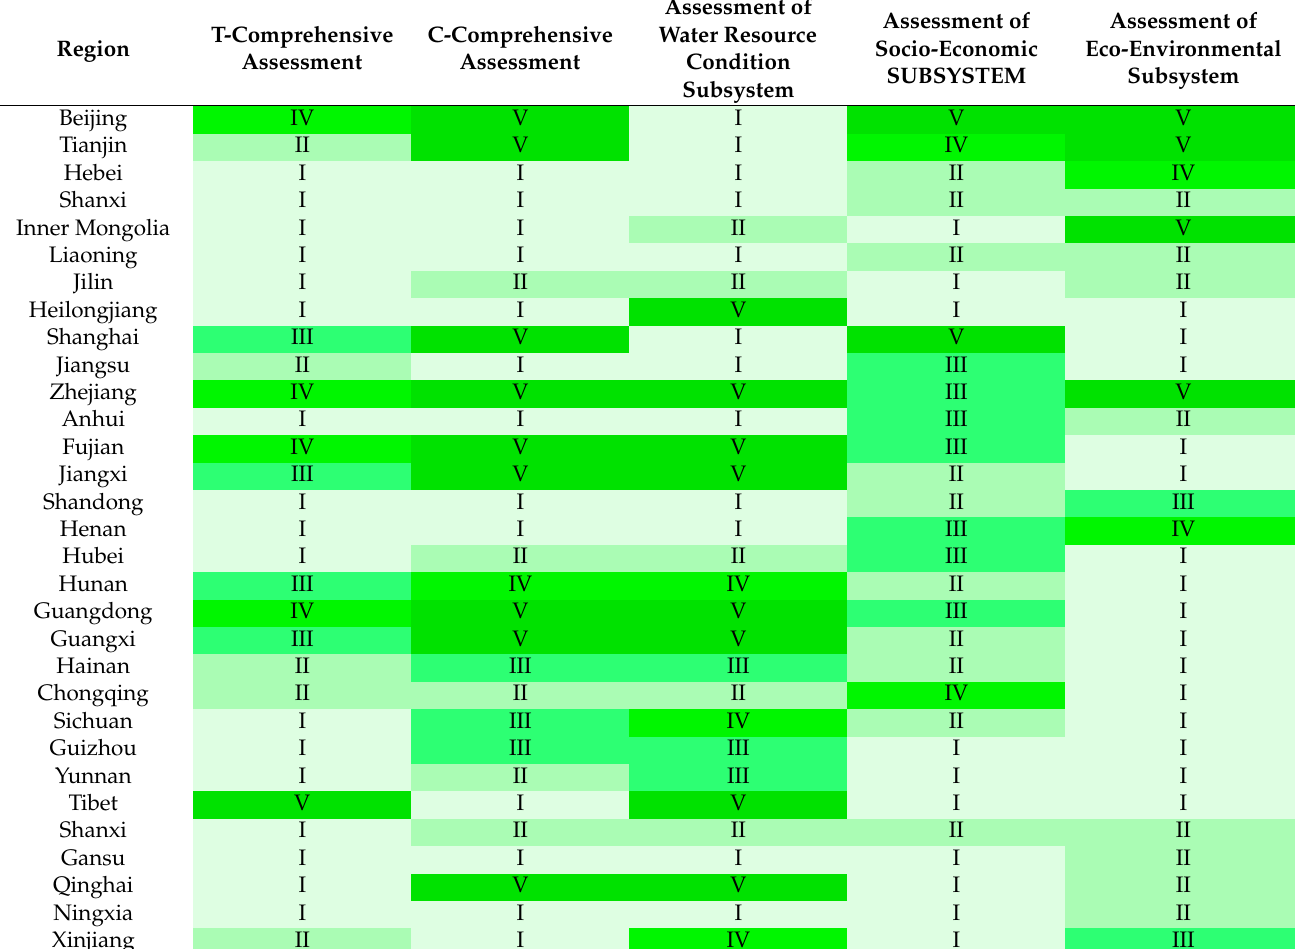
Table 4. Results of sustainability assessment of water resource use in